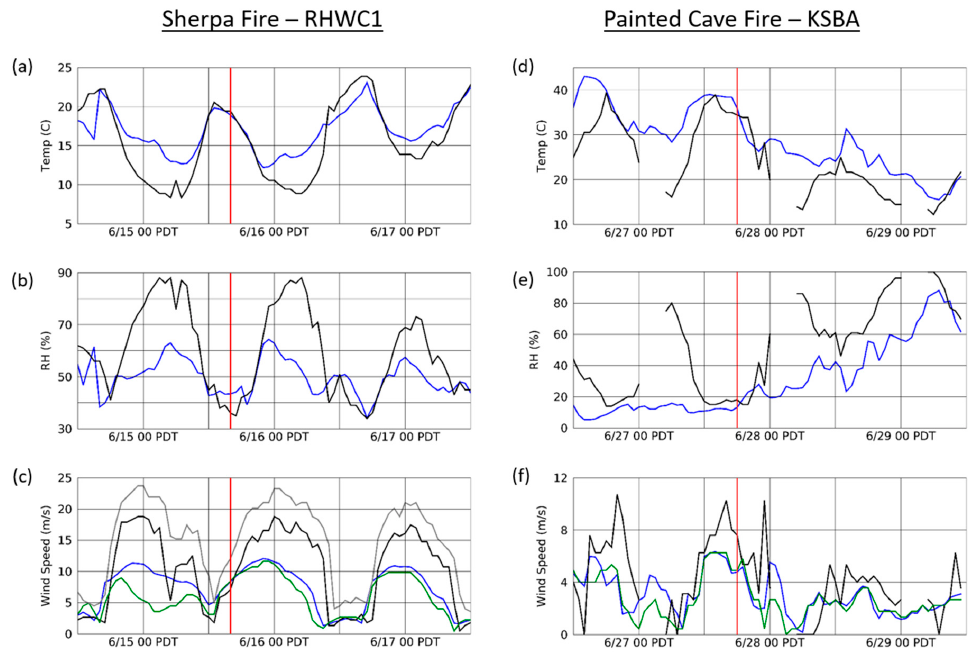
Figure 4. Observed (black) and simulated with WRF (blue) temperature ( a,d ), relative humidity ( b,e ), and wind ( c,f ) at the nearest weather stations for the Sherpa (RWHC1) and Painted Cave (KSBA) fires. WindNinja data was added for wind plots (green lines in c,f ) and observed gust data was available at RHWC1 (grey line in c ). The vertical red line indicates the time of ignition for each fire.